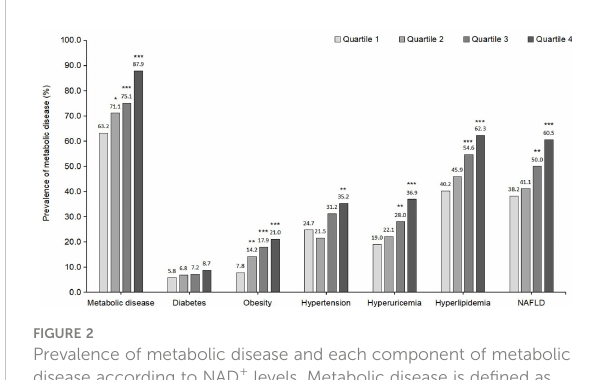
FIGURE 2 Prevalence of metabolic disease and each component of metabolic disease according to NAD + levels. Metabolic disease is de fi ned as hypertension, hyperlipidemia, diabetes, hyperuricemia, obesity, or NAFLD among the whole participants. NAFLD, non-alcoholic fatty liver disease; *indicates p < 0.05; **p < 0.01; ***p < 0.001; Comparison between 2 nd , 3 rd , 4 th vs 1 st quartile of the NAD +